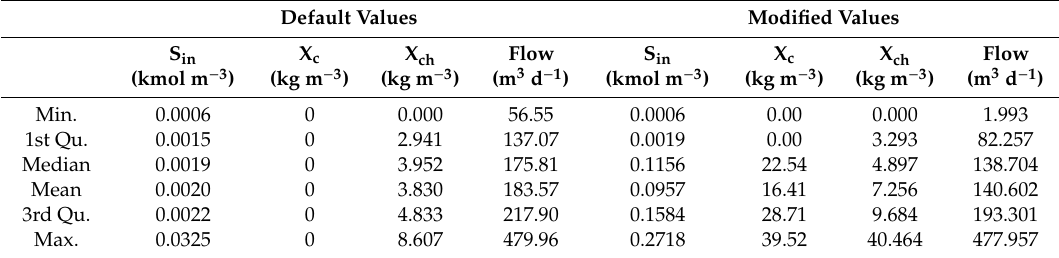
Table 3. Summary of default and the modified values of inorganic nitrogen (S in ), composite (X c ) and carbohydrate (X ch